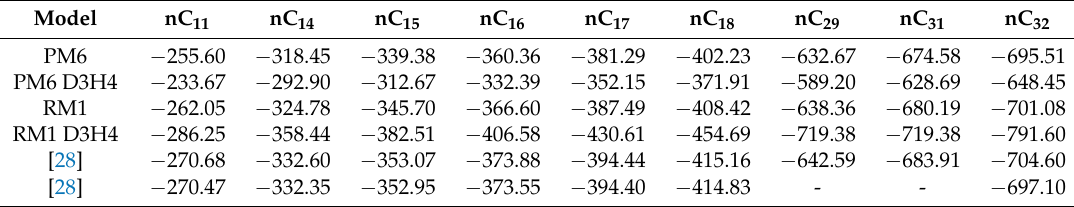
Table 2. Heat of formation (kJ/mol) calculated by AMPAC 10 [31] using the PM6, PM6 D3H4, RM1, and RM1 D3H4 models, and compared with calculated and experimental data [32].